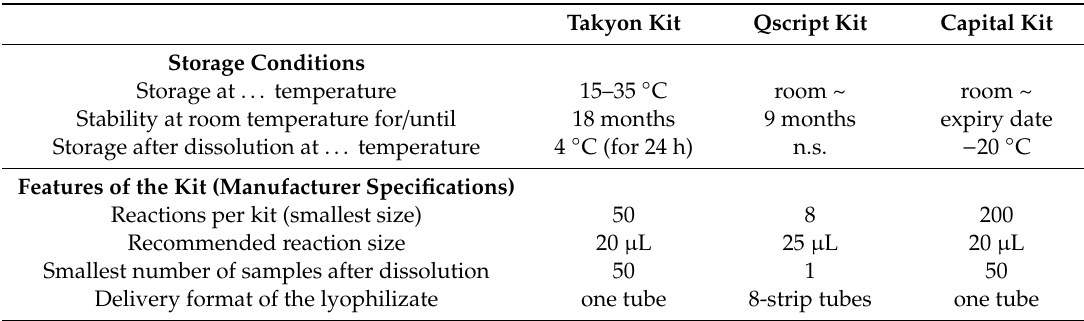
Table 3. Comparative evaluation of the three lyophilized master mix kits with regard to their usability at the pen